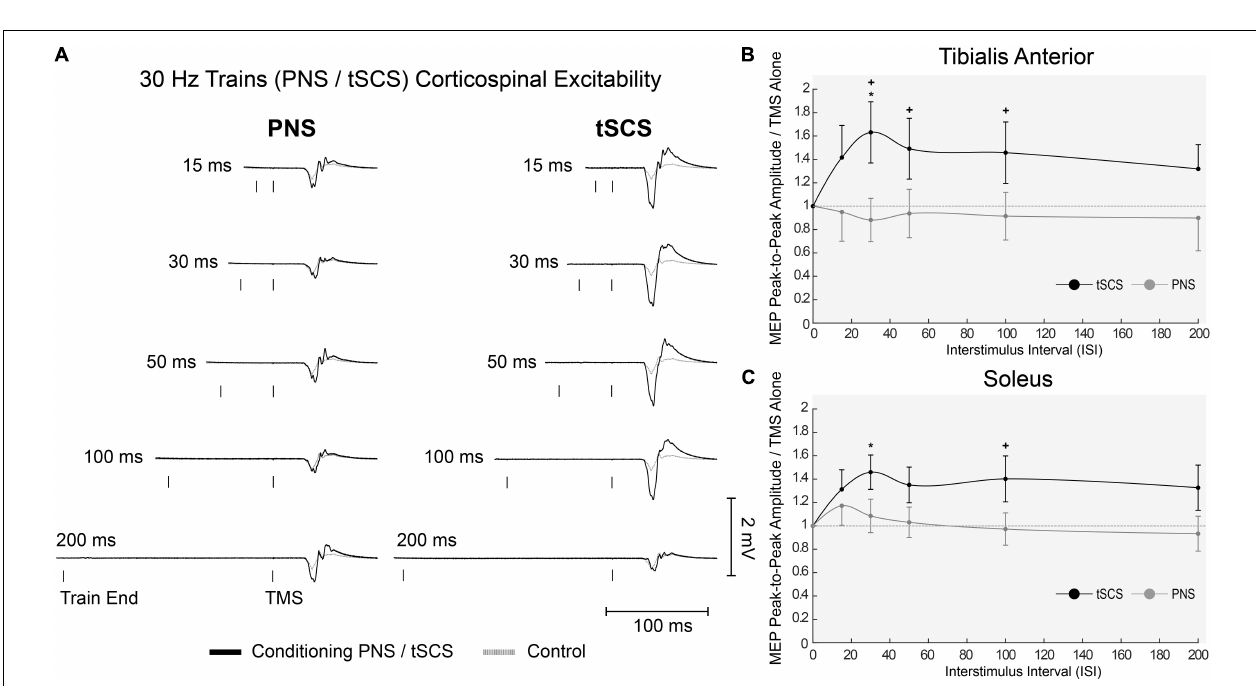
FIGURE 6 | Effects of trains of tSCS (30 Hz) delivered at various ISIs on TMS evoked potentials in the lower limb. (A) Example waveform average (10-control, 4-conditioned trials) EMG responses evoked in the TA from one participant under control (gray dashed line) and tSCS/PNS conditioned (solid black line) at each ISIs. (B) Normalized peak-to-peak MEP amplitudes following either tSCS (black solid line) or PNS (gray solid line) in the TA and (C) Sol muscles at interstimulus intervals. Mean ± SEM; * P < 0.05.